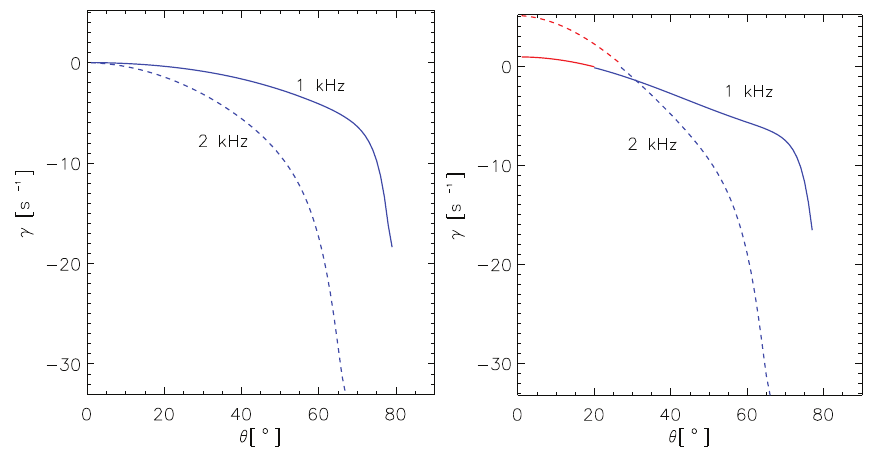
Figure 6. Damping (blue) and growth (red) rate γ of 1 and 2kHz chorus waves at L = 5 obtained by our simulations as a function of wave-normal angle θ , using typical parameters described in Chen et al. (2013). On the left panel, only “Landau” ( ∼ 0.1–1keV) electrons are included along with the core plasma, and on the right panel “resonant” ( ∼ 10–100keV) electrons are also